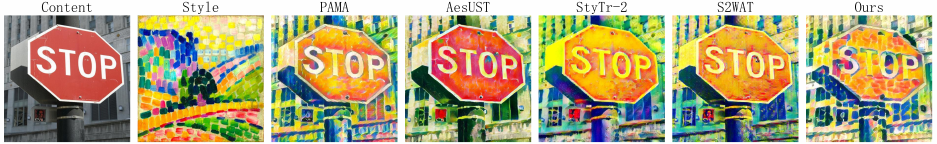
Figure 1. The stylized comparison graph, comparing our method with PAMA [15], AesUST [11], StyTr-2 [12], and S2WAT [13], showing that the stylized image is square; therefore, the stylized image generated by the model should also be